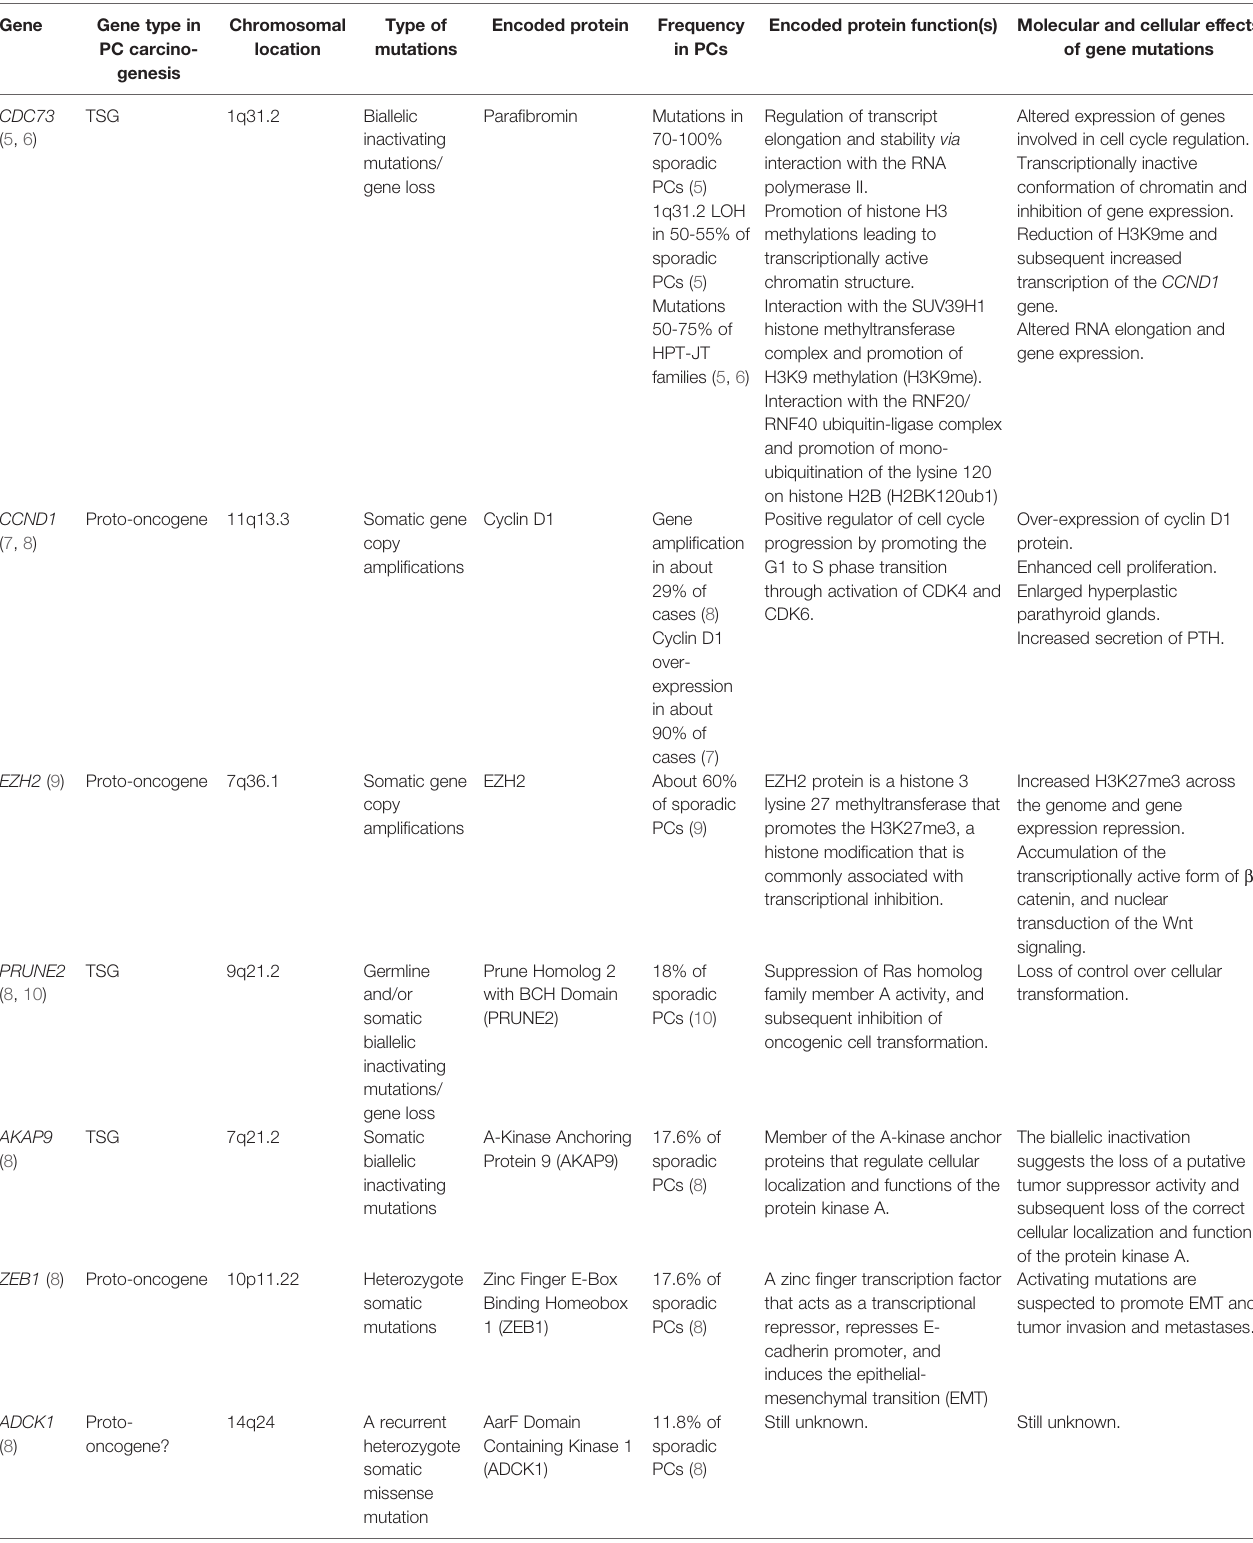
TABLE 1 | Main genetic determinants in parathyroid